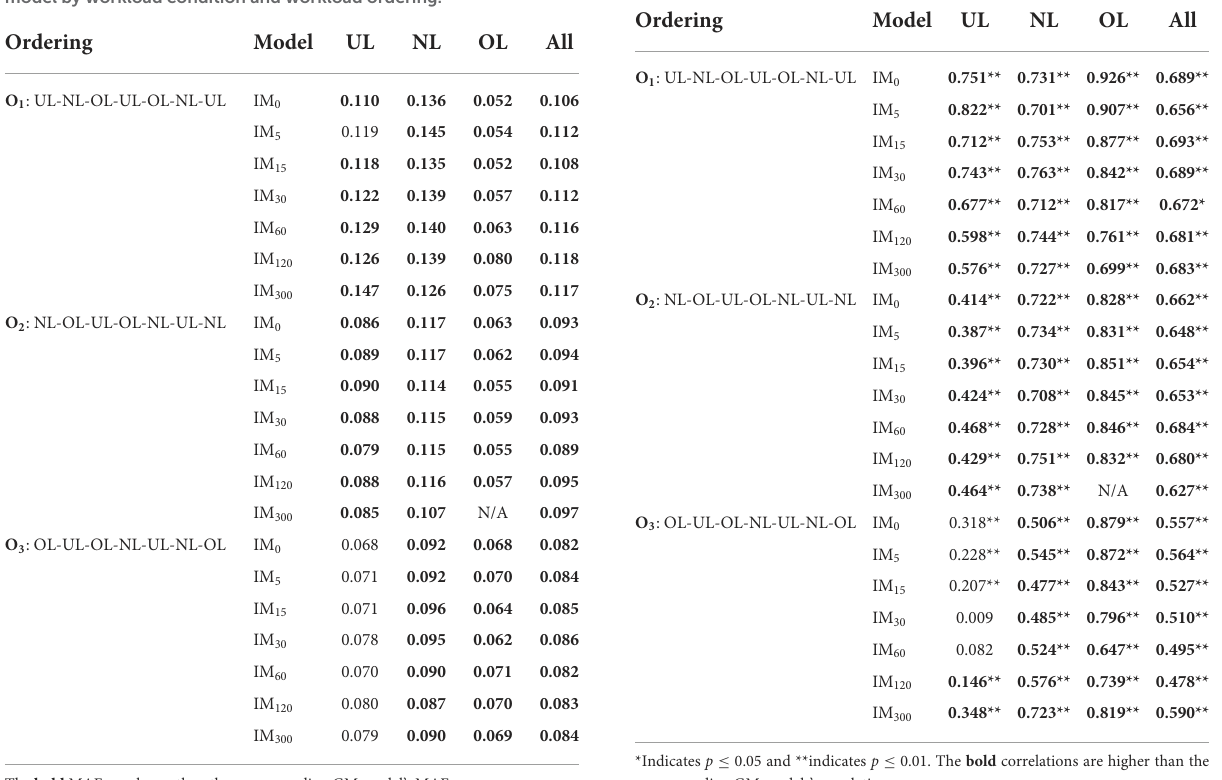
TABLE 4 The Pearson’s correlations between the predicted performance and actual performance for each individualized model variant by workload condition and ordering.